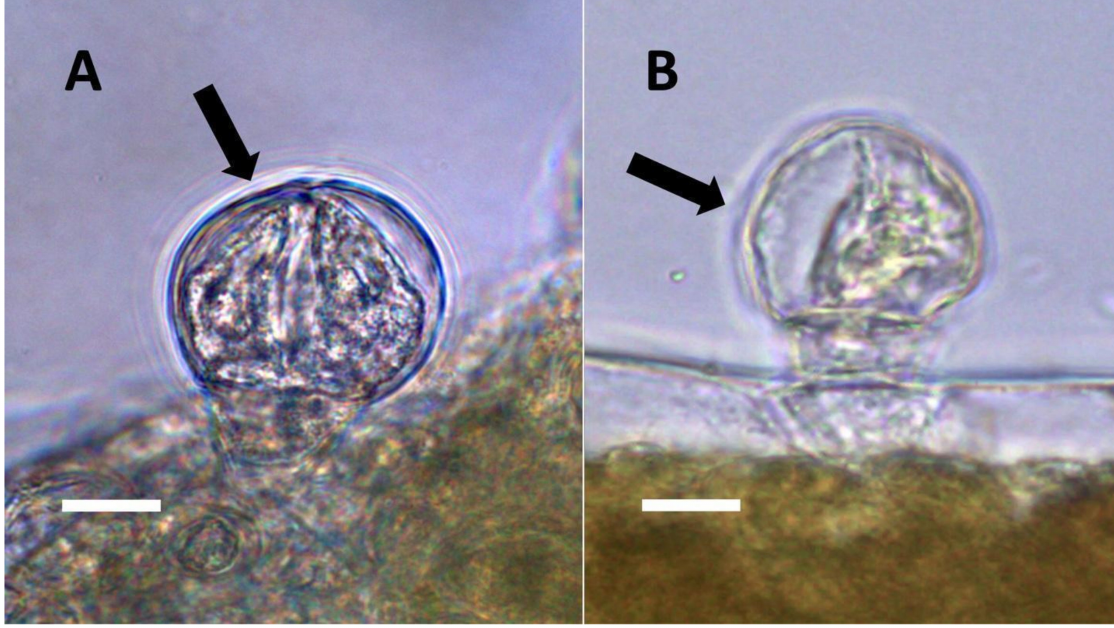
Figure 13. Perilla frutescens seedling leaf glandular trichomes (arrows) stained for nitrate. ( A ) Non- sterilized seedling glandular trichome (arrow) stained with acidified diphenylamine to show nitrate (blue-purple color) around bacteria (Bar = 10 µ m). ( B ) Glandular trichome on seedling developed from surface-sterilized seeds, stained with acidified diphenylamine showing smaller size and absence of nitrate staining internally (Bar = 10 µ